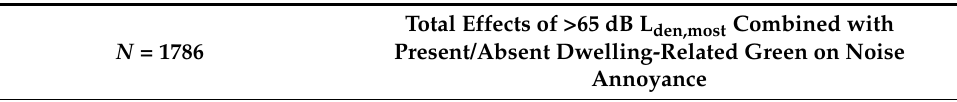
Table 11. Joint associations of exposure to road traffic noise (>65 dB L den,most ) and present/absent dwelling-related green with perceived noise control and noise annoyance 1 .